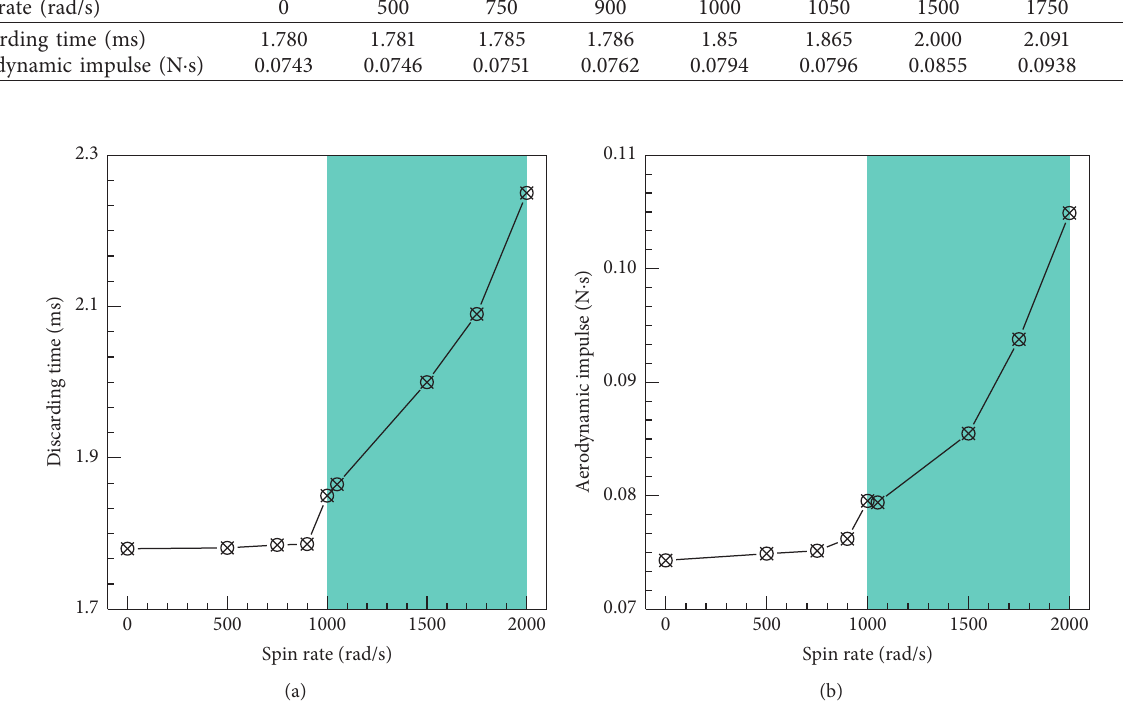
Figure 16: Discarding characteristic. (a) Discarding time. (b) Aerodynamic